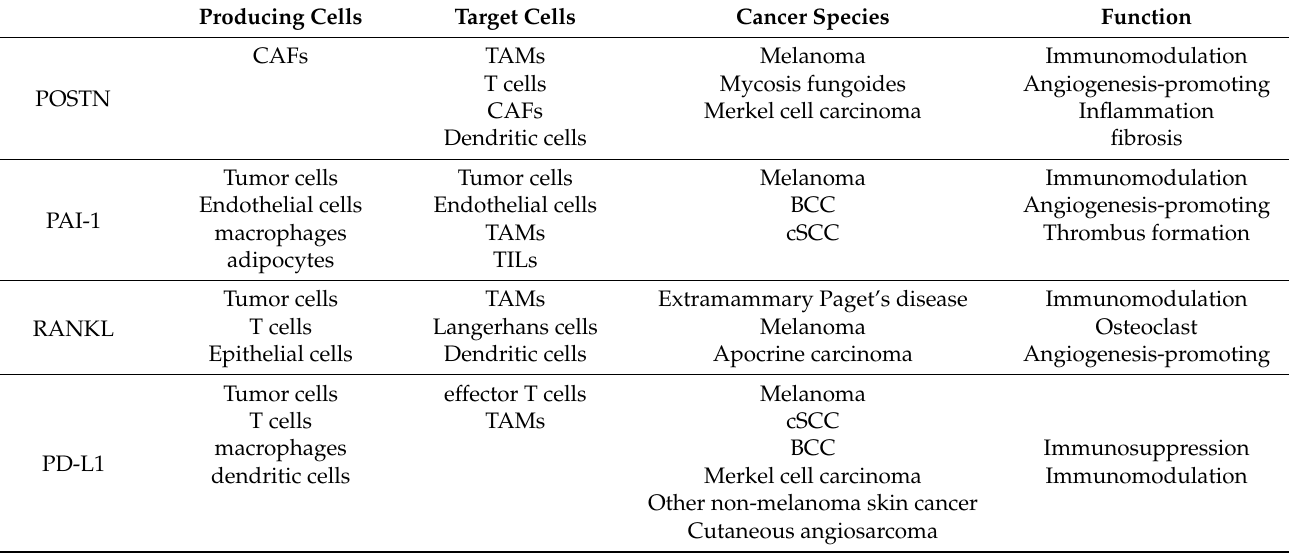
Table 1. Possible immunological pathways in lesional skin of invasive